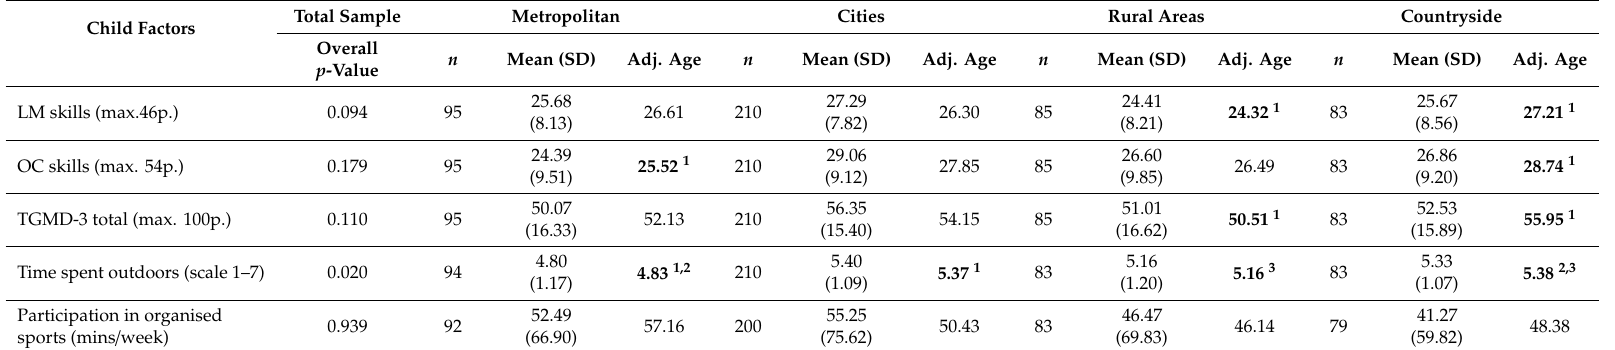
Table 6. Residential density: di ff erences in